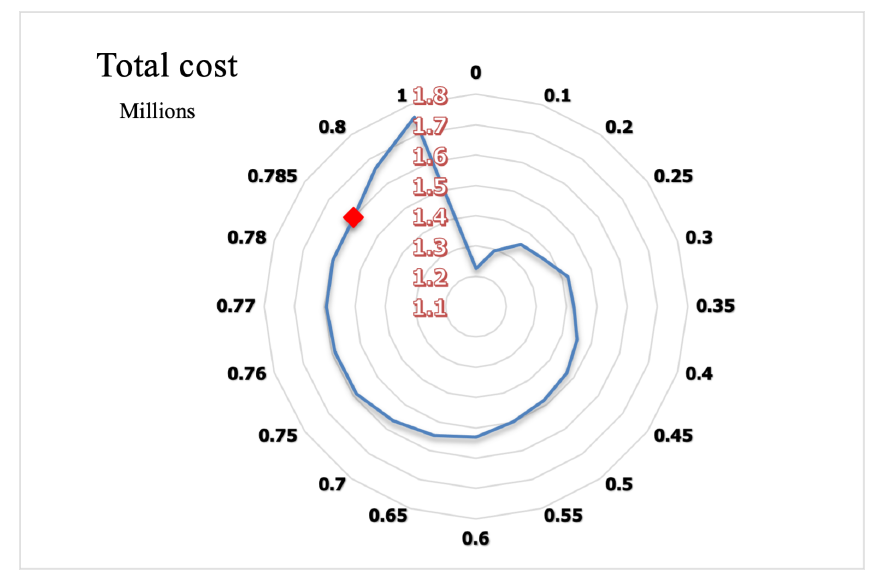
Figure 5. Analysis of the